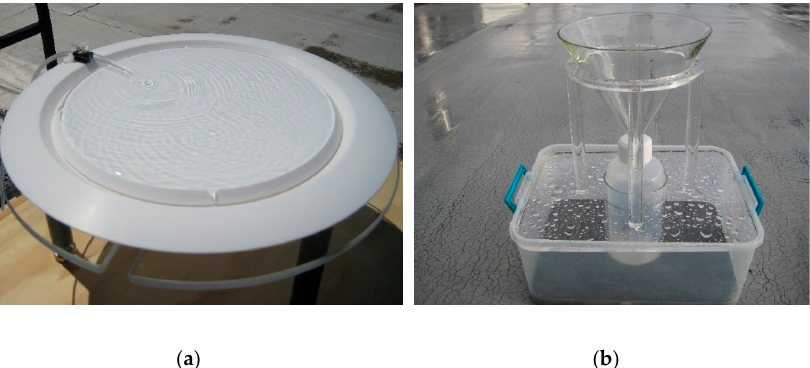
Figure 2. ( a ): Dry deposition sampler. Plate diameter is 35 cm. ( b ): Wet deposition sampler. Funnel diameter is 20 cm.